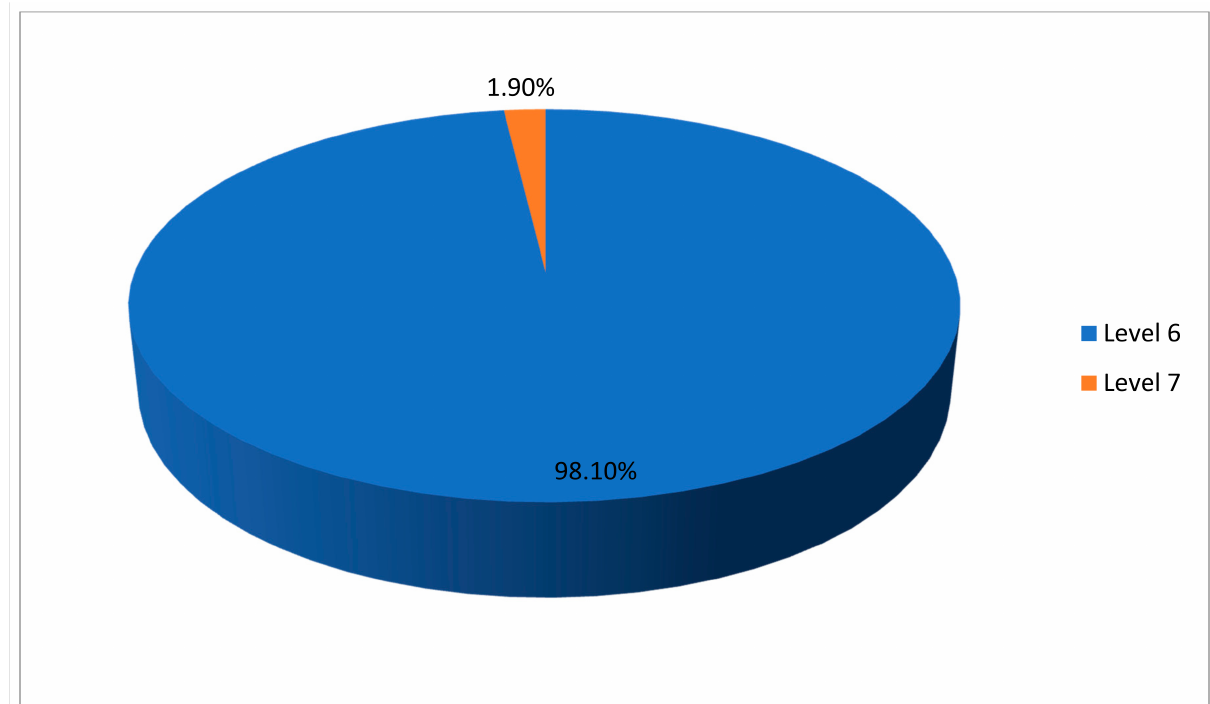
Figure 4. Percentages for university